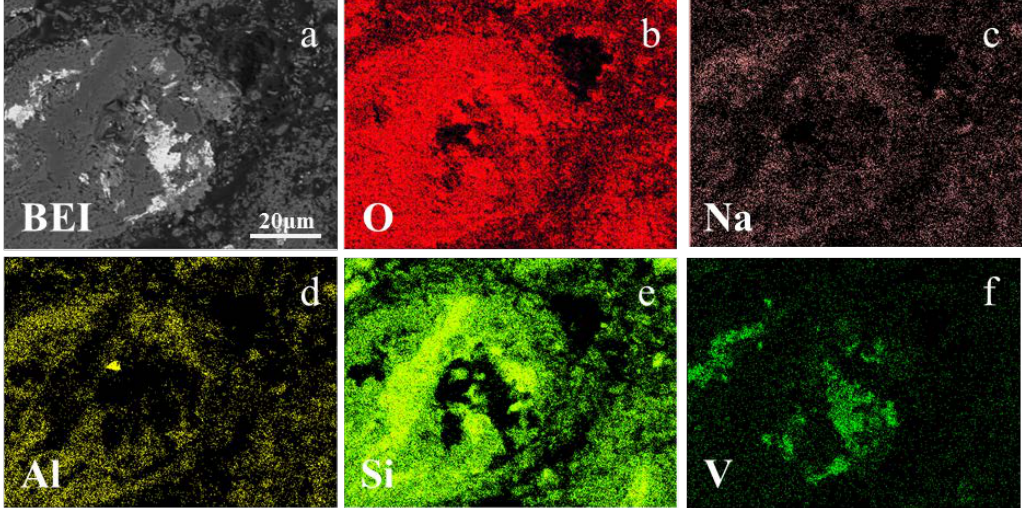
Figure 4. ( a ) BEI of the third type of vanadium-bearing grain in water leaching residue, EDS elemental distribution: ( b ) O, ( c ) Na, ( d ) Al, ( e ) Si, and ( f ) V.